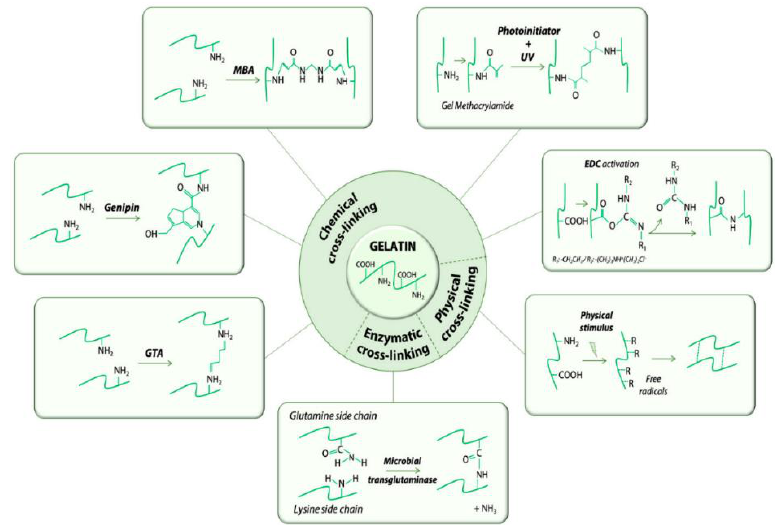
Figure 1. Schematic representation of crosslinking methods used to formulate gelatin nano-materials. Adapted and modified with permission from [14].